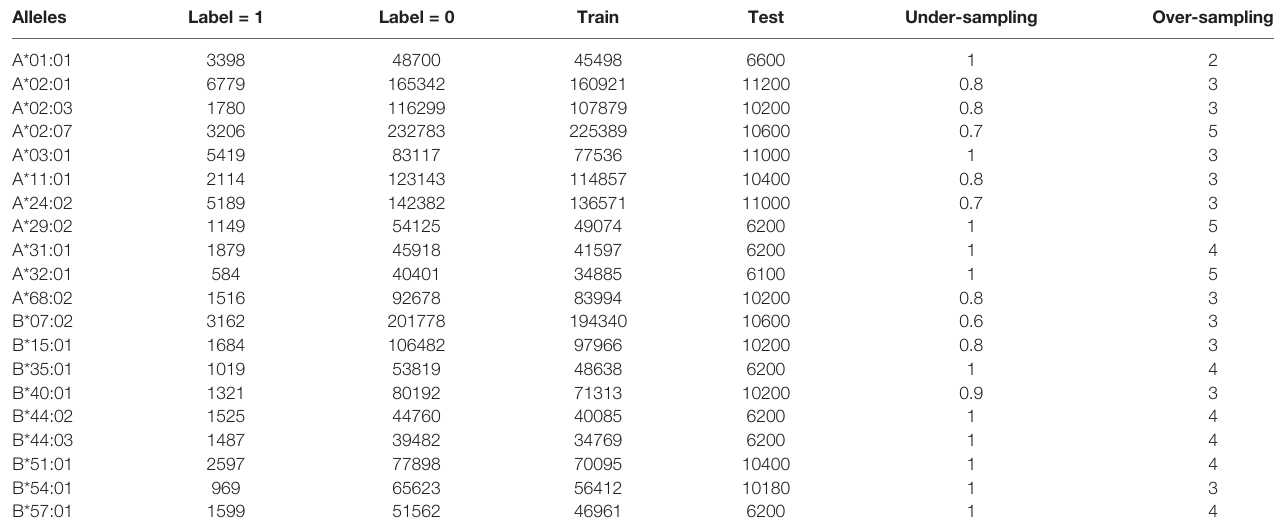
TABLE 1 | The Training Detail on different HLA alleles. Alleles Label = 1 Label = 0 Train